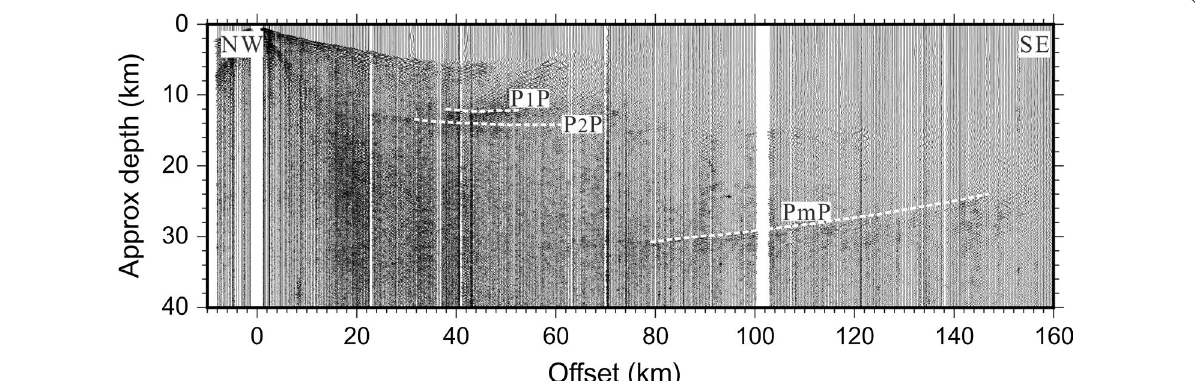
Fig. 5 Normal moveout (NMO) correction of the SP1 seismic record. The normal moveout velocity is 6.1 km/s. This NMO record section highlights the P1P and P2P wide-angle reflections. The white dashed lines indicate the picked travel